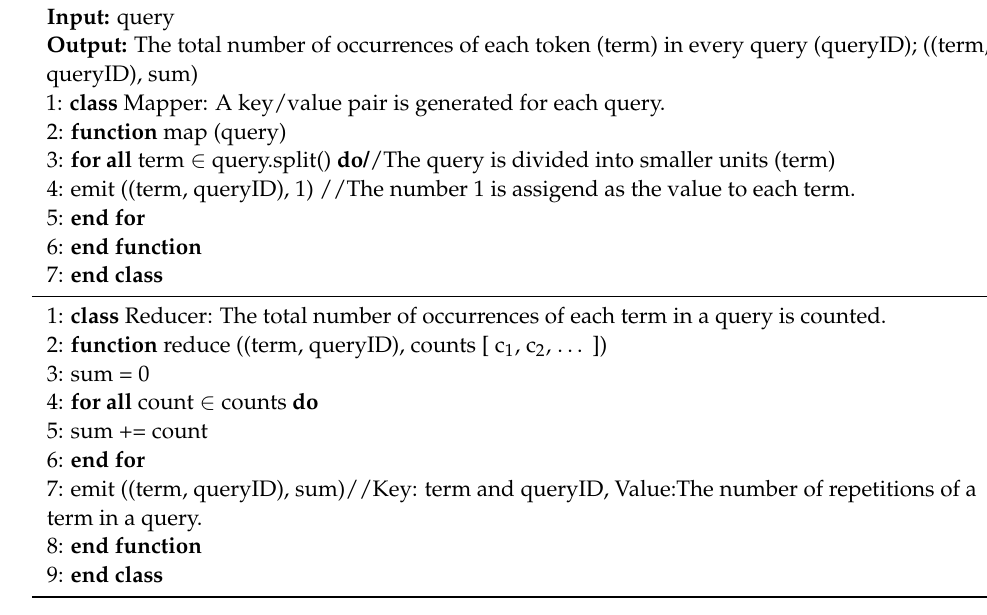
Algorithm 1: The number of each term in every query